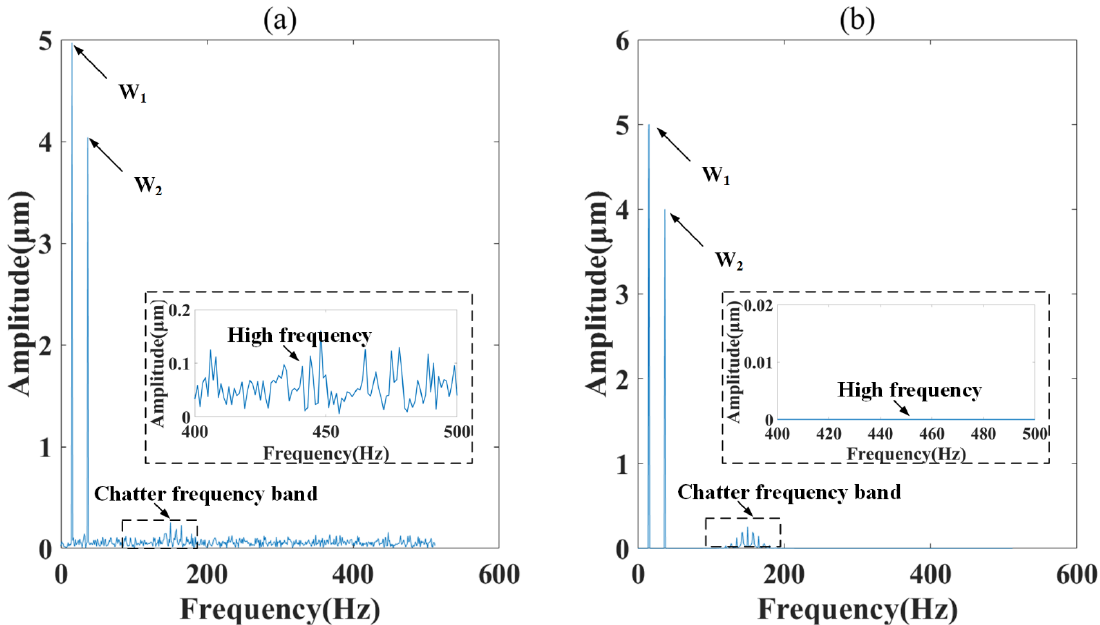
Figure 2. Frequency spectrum. ( a ) Spectrogram of the raw signal x ( t ). ( b ) Spectrogram of the reconstructed signal µ after VMD.